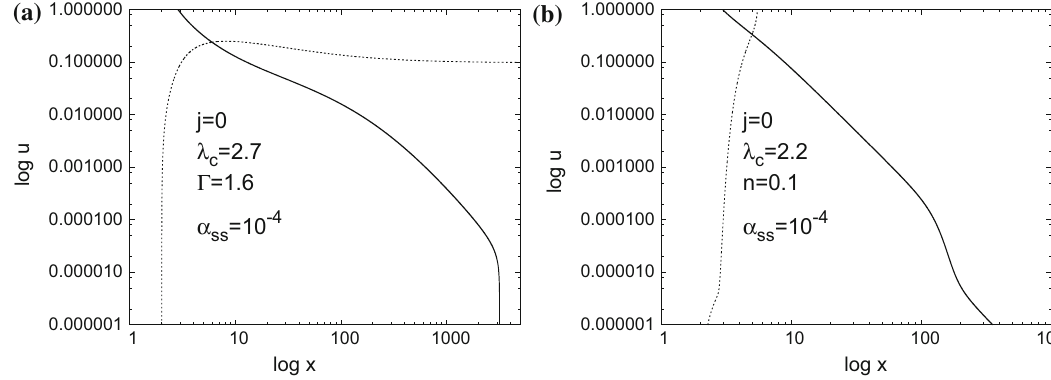
Fig. 2 a , b areplotsoflog( u )vs.log( x )forviscous( α ss = 10 − 4 )accretiondiscflowaroundanon-rotatingBHforadiabaticandMCG,respectively. Accretion and wind curves are depicted by solid and dotted lines,